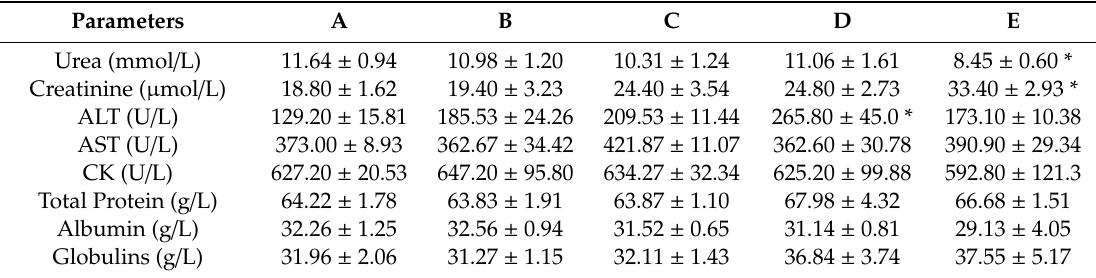
Table 9. Biochemical parameters (mean ± SEM) of female ICR mice in subacute toxicity study of CELE. Parameters A B